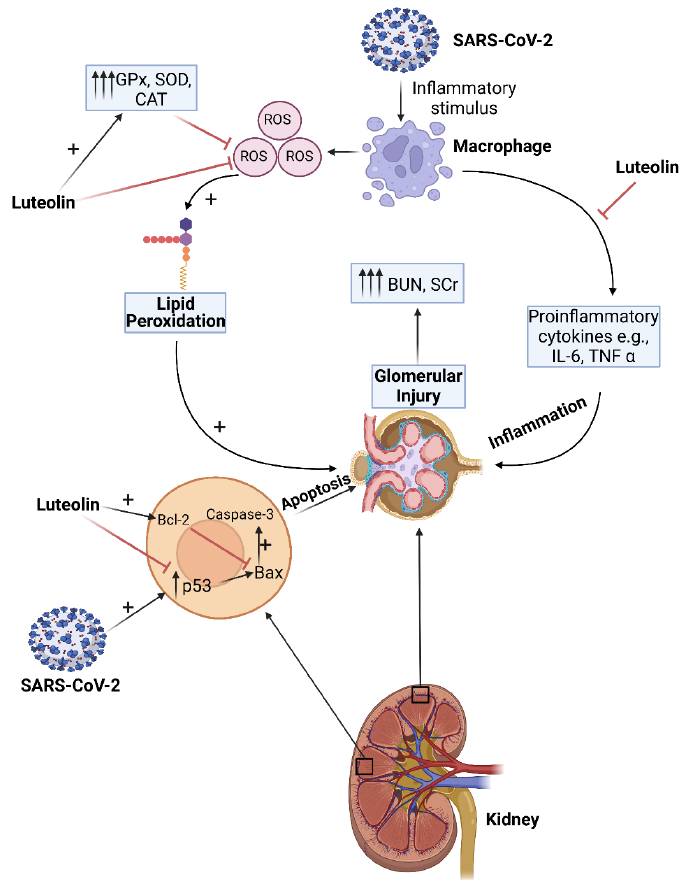
Figure 3. Luteolin is a potential renoprotective drug against COVID-19-associated AKI. Luteolin attenuates oxidative stress and lipid peroxidation by acting as an anti-oxidant and restoring anti- oxidant enzyme activities, which detoxify reactive oxygen species (ROS). Luteolin also acts as an anti-inflammatory by inhibiting activation of NF-kB, which lowers production of pro-inflammatory cytokines (TNF- α , IL-6 and IL-1 β ). Moreover, luteolin is an antiapoptotic which inhibits p53 induction and Bax expression while increasing Bcl-2 expression. This figure was created with BioRender.com (accessed on 25 January